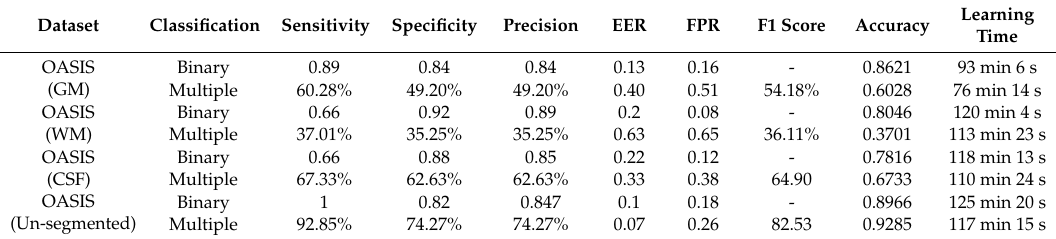
Table 3. Results of transfer learning on four datasets.